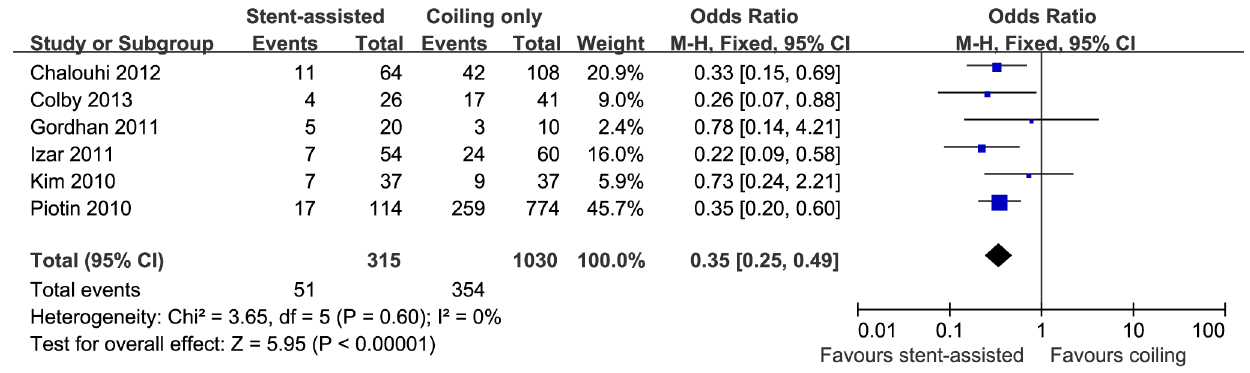
Figure 5. Forest plot of recurrence rate comparing stent-assisted coiling versus coiling only. Fixed-effect model was applied.